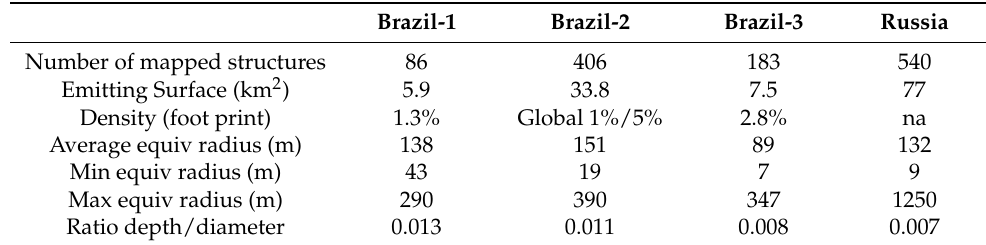
Table 1. Comparison of the characteristics between the 3 mapped areas in Brazil and the Borisoglebsk area (Russia), this last zone has been studied by [8]. Brazil-1 Brazil-2 Brazil-3 Russia Number of mapped structures 86 406 183 540 Emitting Surface (km 2